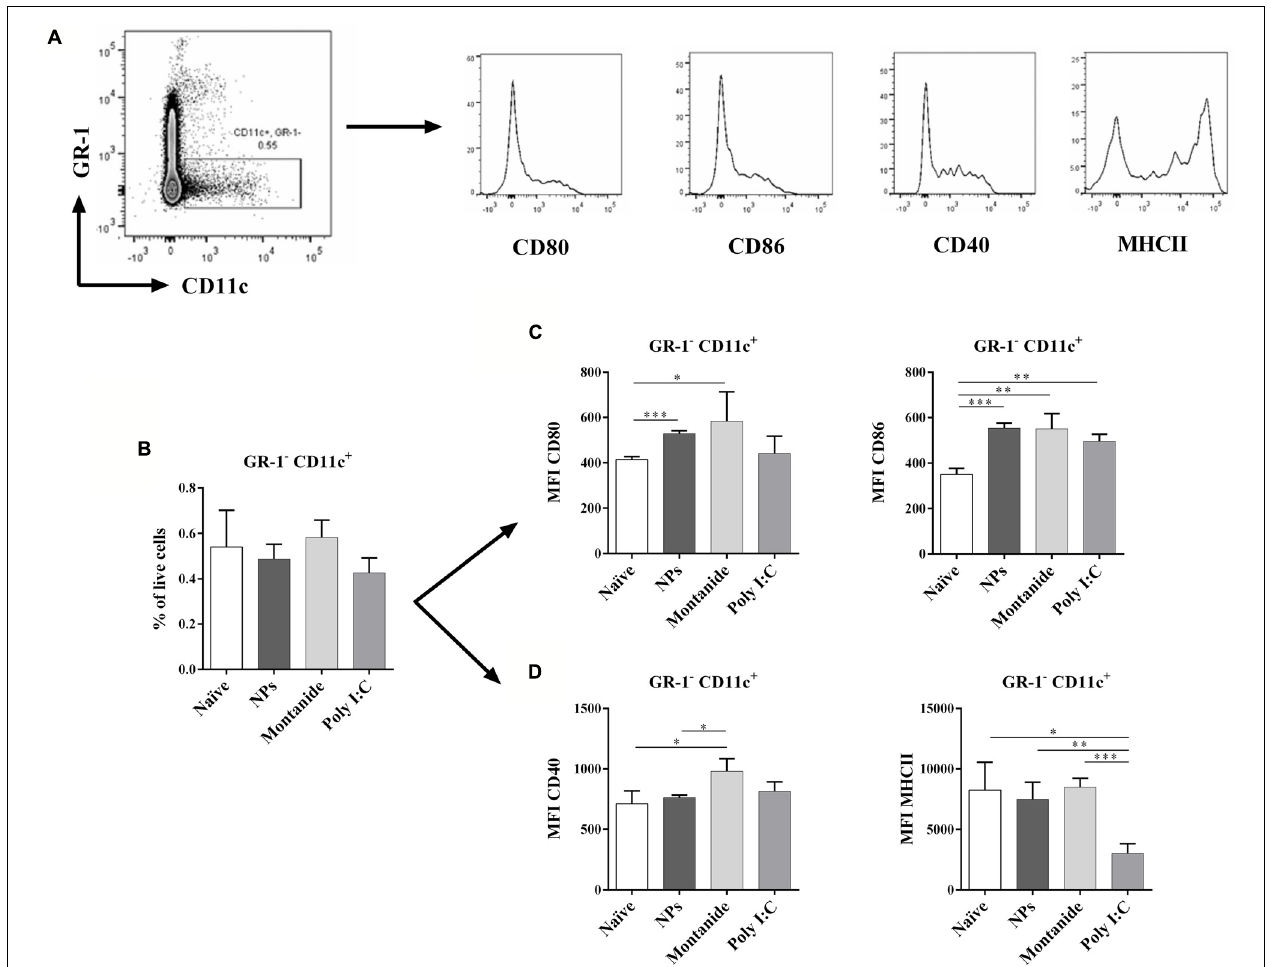
FIGURE 4 | Dendritic cell activation in dLNs after injection with PSNPs, Montanide, and Poly I:C. Mice (BALB/c) were injected once intradermally at the base of tail with the different adjuvants alone. 48 h after injection, mice were sacrificed, local (inguinal) dLNs were harvested and the levels of CD11c + DCs and various activation markers were assessed by flow